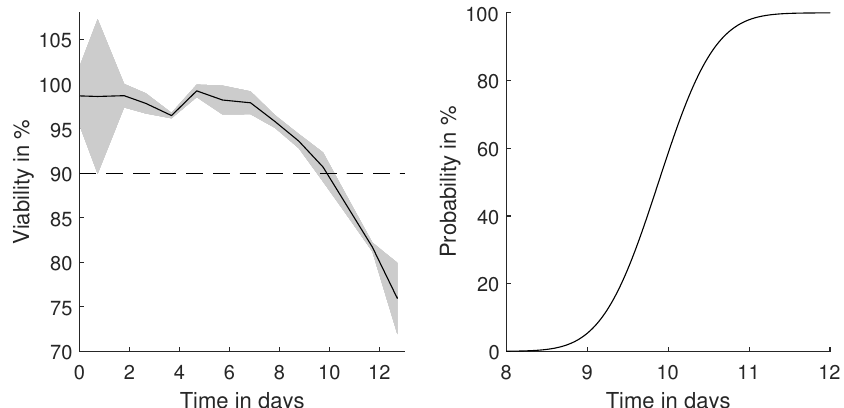
Figure 7. Determined CHO cell viability throughout a fed-batch experiment with a harvest threshold of 90% viability. Based on the propagated uncertainty, the probability of crossing the threshold can be